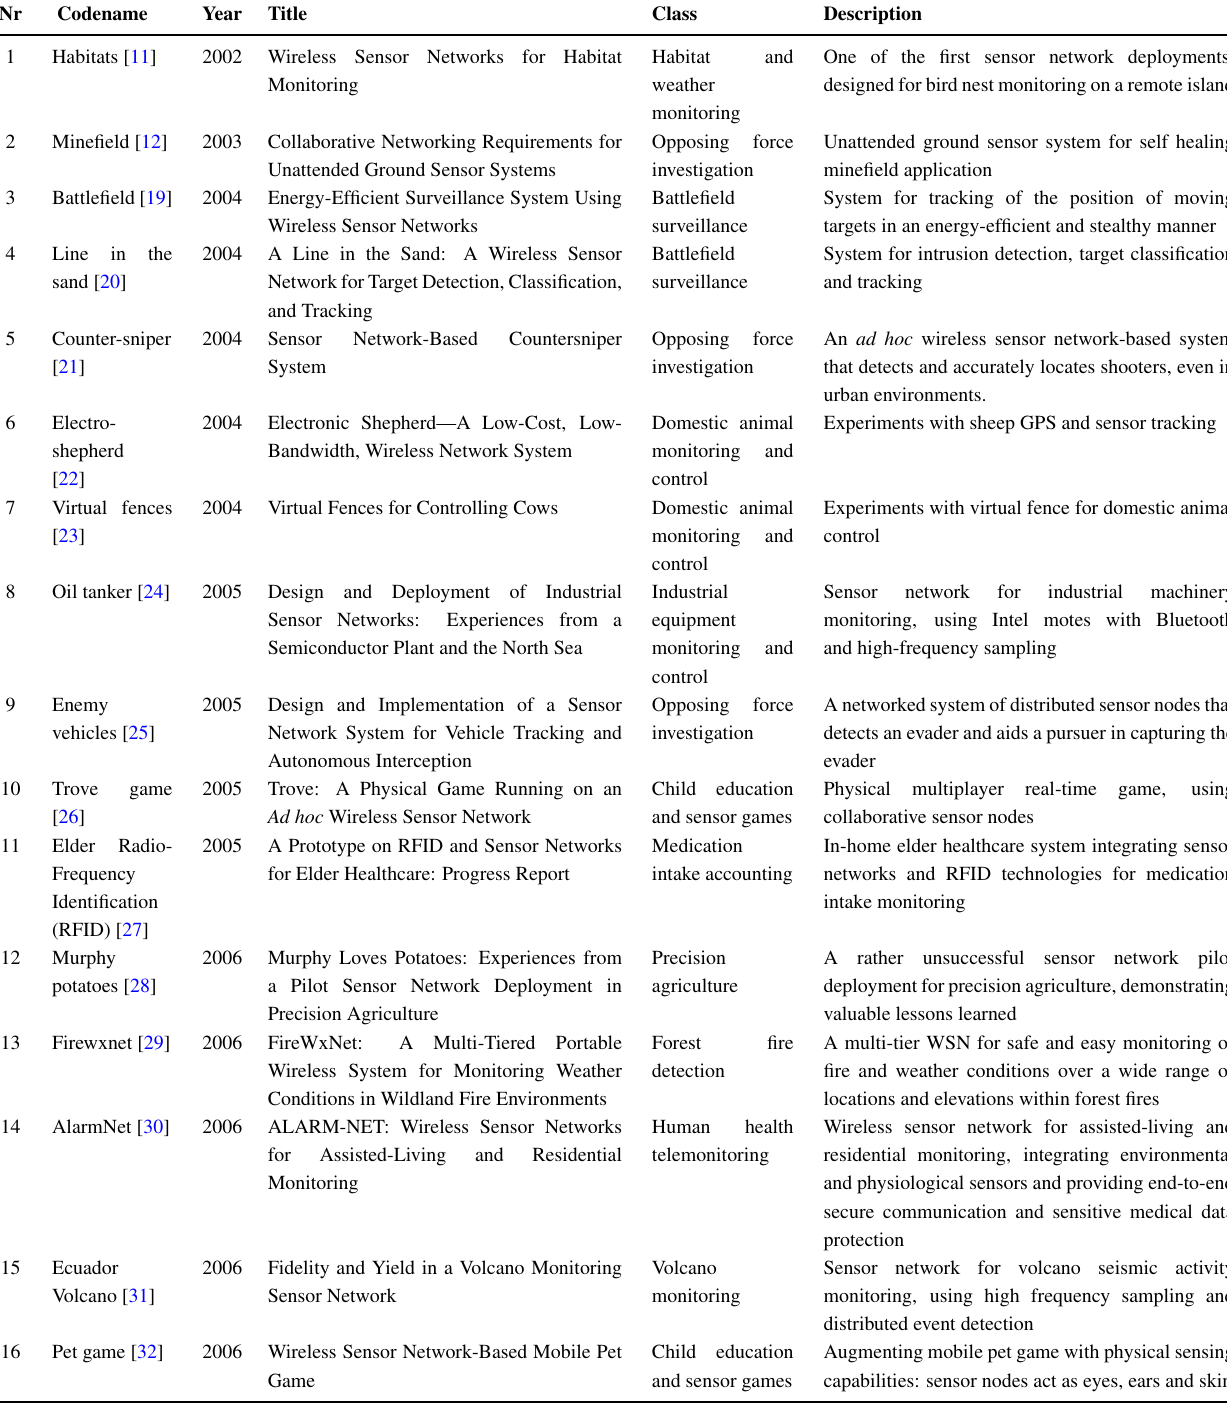
Table 1. Deployments: general